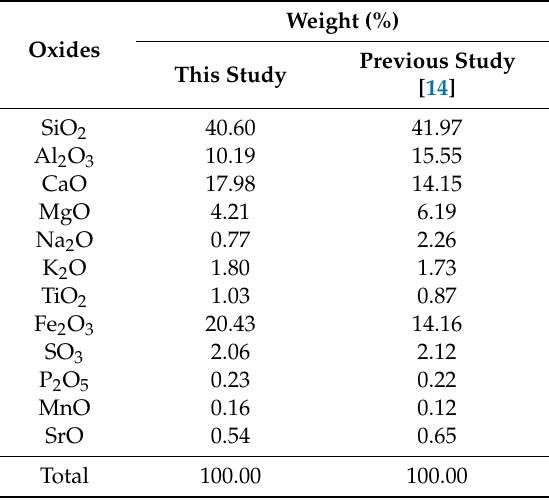
Table 1. Chemical composition of FA.